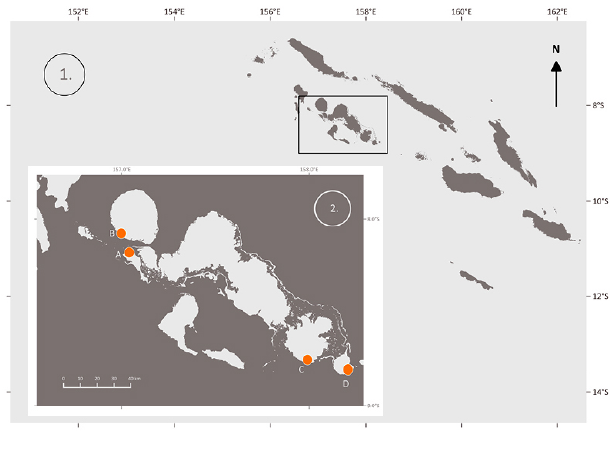
Fig. 1. Solomon Islands (main map) and Western Province (inset) showing study sites